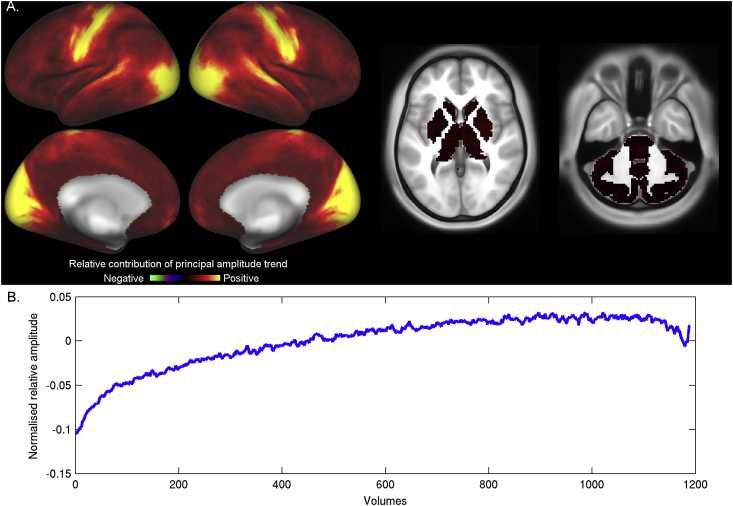
The first principal component of variance changes over time displays the characteristic increase in amplitude from the start to the end of the scan (temporal weights shown in panel B). The spatial weights for this principal component are shown in panel A, and demonstrate that this effect is mostly localised to the primary visual and primary sensorimotor regions.